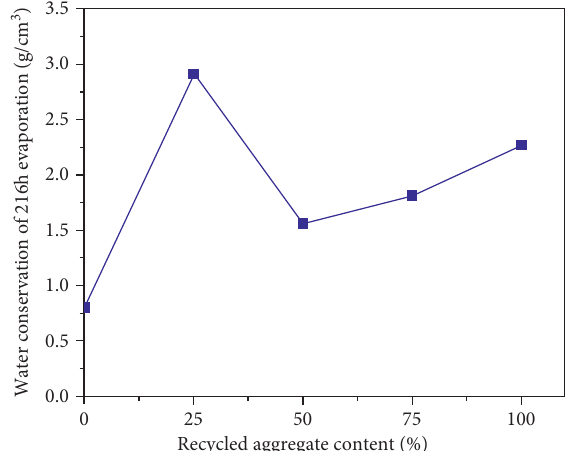
Figure 17: Relationship between water retention and RA